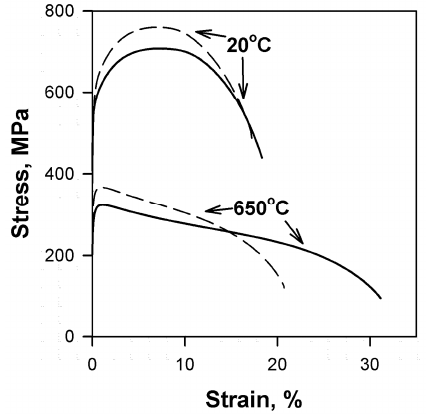
Figure 2. Tensile behavior of the 9Cr2W (solid lines) and 9Cr3W (dash lines) steels after heat treatment consisting of normalizing at 1050 °C and tempering at 750 °C. Tensile tests were carried out at room temperature and at 650 °C (creep test temperature). Table 2. Values of yield stress (YS), ultimate tensile stress (UTS), and ductility ( δ ), obtained under tension, at room temperature and 650 °C for the 9Cr2W and the 9Cr3W steels.